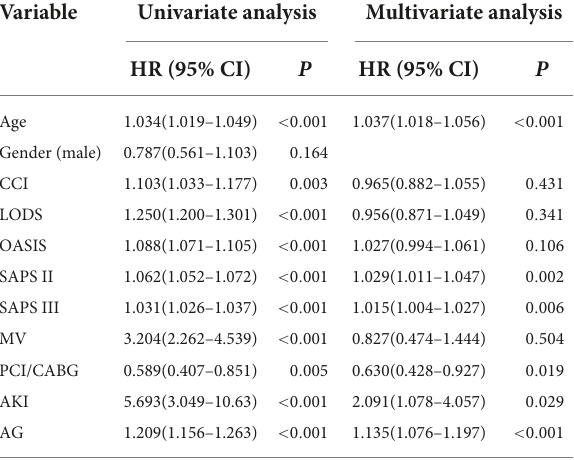
TABLE 4 Cox regression analyses of risk factors for in-hospital mortality among coronary care unit patients with AMI (before